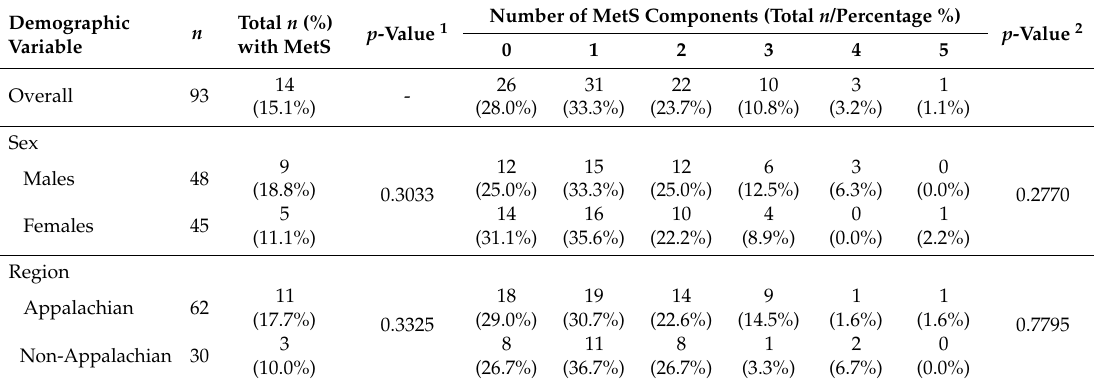
Table 6. Frequency of metabolic syndrome and number of metabolic syndrome